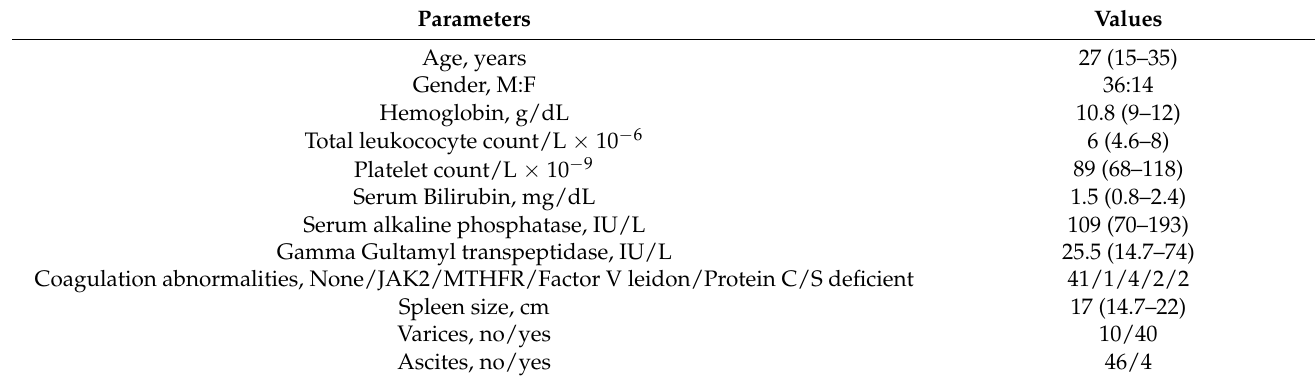
Table 1. Basic attributes in portal cavernoma cholangiopathy.